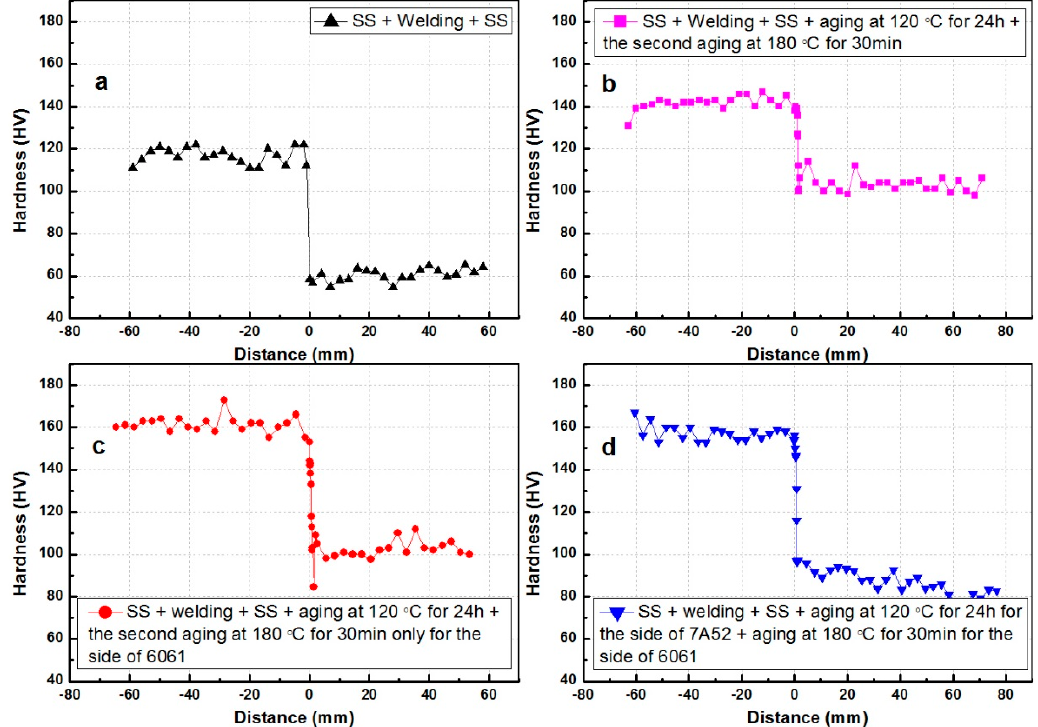
Figure 4. Microhardness profile along the middle section of the weld joint of 7A52 and 6061 Al alloys with pre-solid-solution and different post-heat-treatment (solid solution treatment and aging).